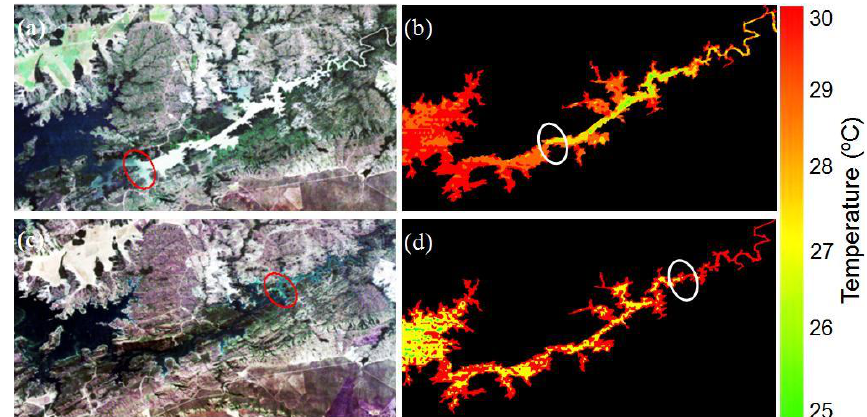
Figure 4: Temporal evolution of the thermal structure (upper panel) and the Wedderburn and Lake numbers (lower panel) at Station 13. Figure 5: Satellite images (in true-color composition) acquired on March 26 (a) and July 16 (c), showing the seasonal plunge point variation (red circles), and the water surface temperature (b, d) estimated from the thermal band (band 6) of Landsat 5 TM.